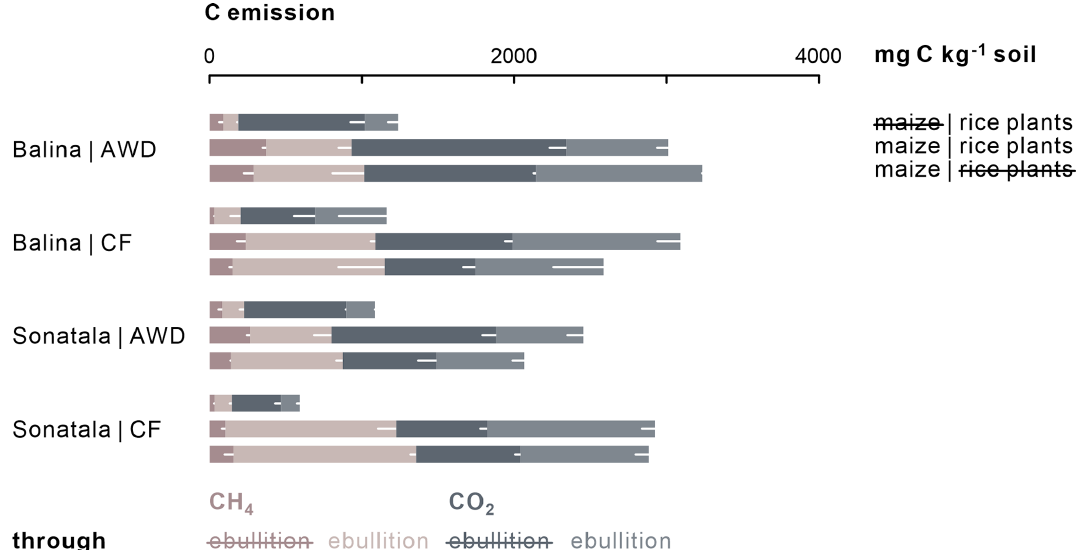
Figure 4. Total cumulative C emissions (average − standard error of three or two replicates, represented by white bars) from maize-amended soils were two to fourfold of those from unamended pots ( P < 0 . 001). In addition, relatively more C was emitted through ebullition under CF ( P < 0 . 001) and upon addition of maize shoots ( P < 0 .